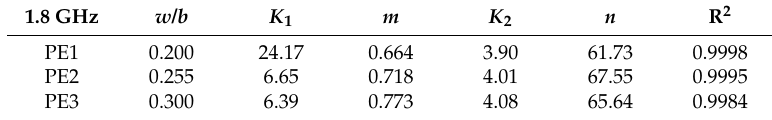
Table 5. Regression coefficients and goodness of fits for measured data at 1.8 GHz.